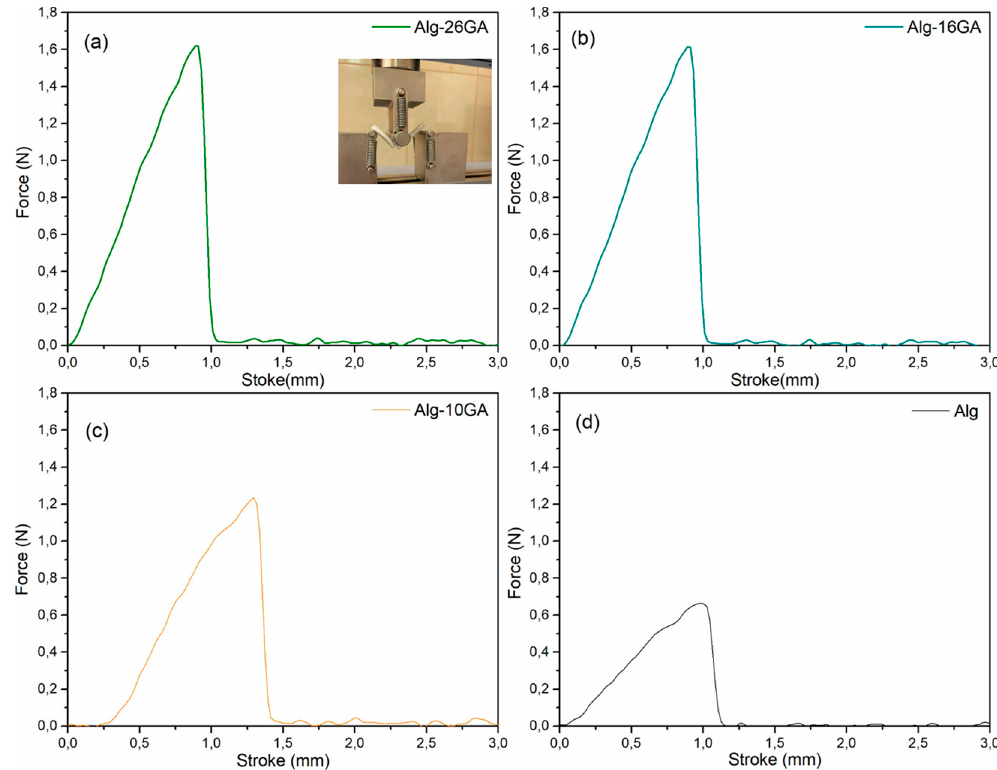
Figure 11. Force–displacement curve of Alg-xGA composites: x = 0 ( a ), x = 10 ( b ), x = 16 ( c ), and x = 26 ( d ); dried composites in three-point bending test configuration.